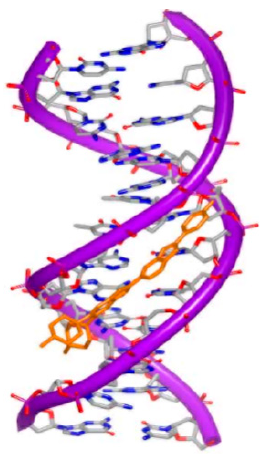
Figure 7. Crystal complex of DNA duplex and Hoechst 33528 (PDB code: 8BNA). The orange structure represents the small molecule; the purple structure represents the backbone of nucleic acid; the blue and red atoms in the molecule represent nitrogen and oxygen atoms, respectively.